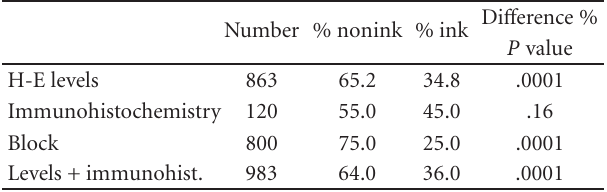
Table 2: Comparative use of resources between nonink and ink groups.